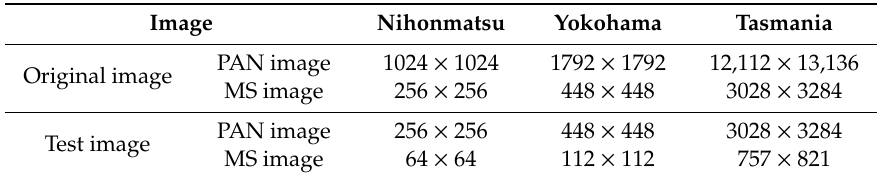
Table 1. Characteristics of the original and test images of the image datasets. MS: multi-spectral, PAN: